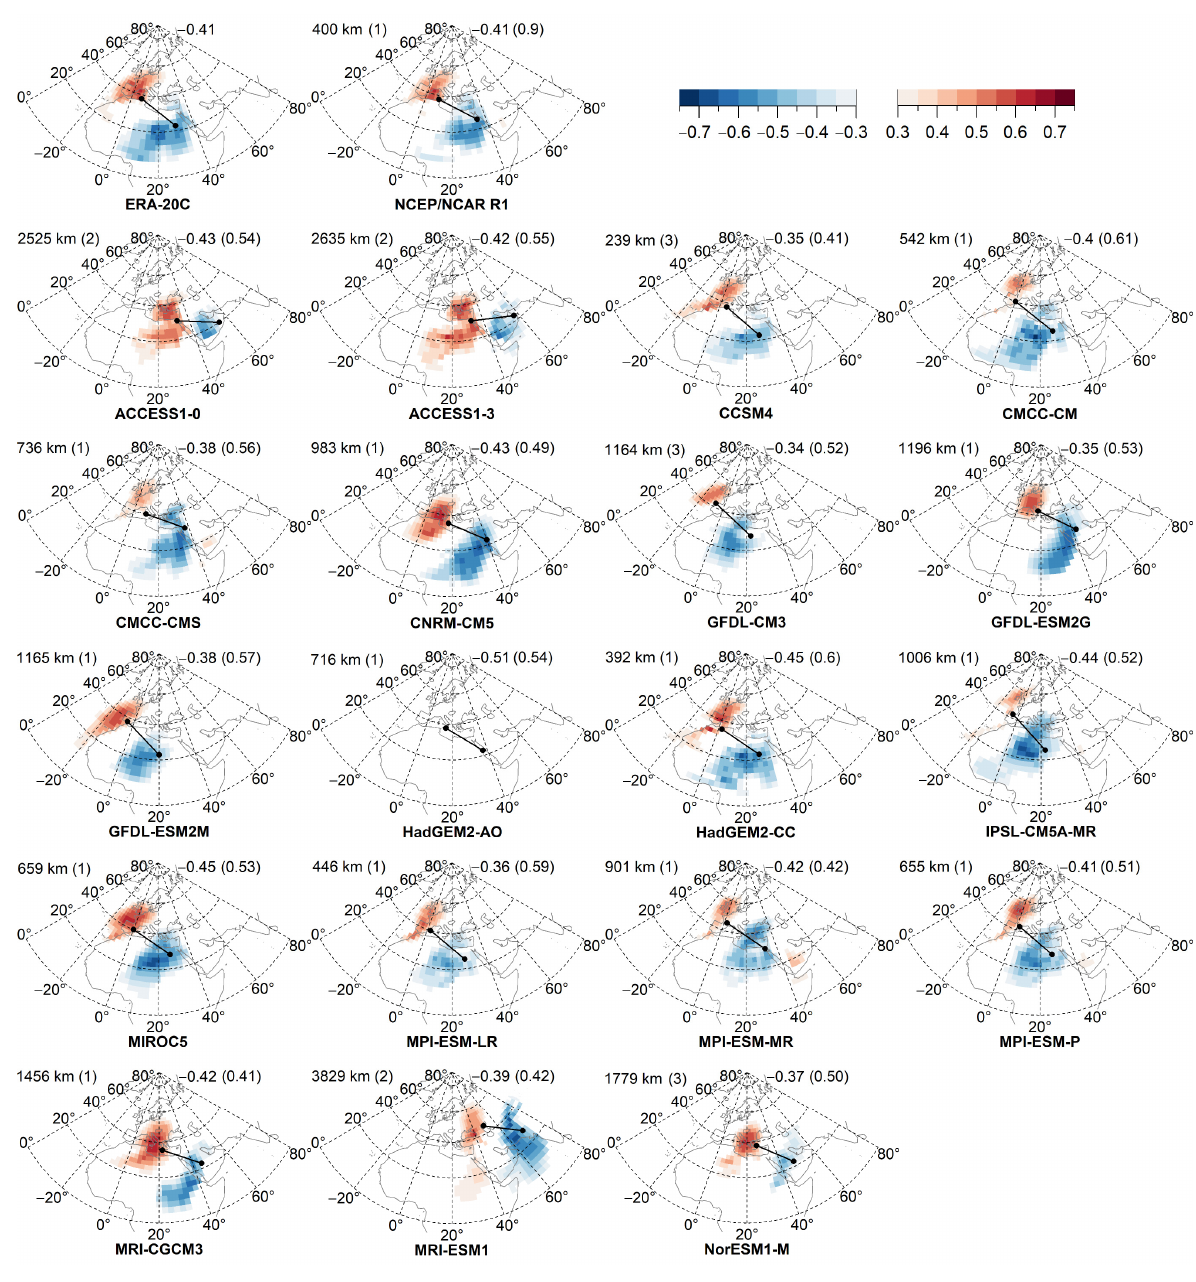
Figure 8. Significant correlations (< − 0.3) between t 2m and the mobile teleconnection index based on the ACs of the cluster MED for the period 1976–2005 in cases of the reanalyses and the GCMs. The GCMs are in alphabetical order. The identified ACs are denoted with black dots connected with black lines. The average distances—between the ACs obtained from the NCEP/NCAR R1 or the GCMs and the ACs of the reference cluster MED (ERA-20C)—are plotted on the top-left corner of each map according to Table S6 of the Supplementary Material. The type of the clusters in accordance with Table S7 of the Supplementary Material are also texted (in rounded brackets) on the top-left corner of each map. The negative correlations associated with the ACs and the MCC max values (in rounded brackets) can be seen in the top-right corner of each map (those values are also presented in Table S6 of the Supplementary